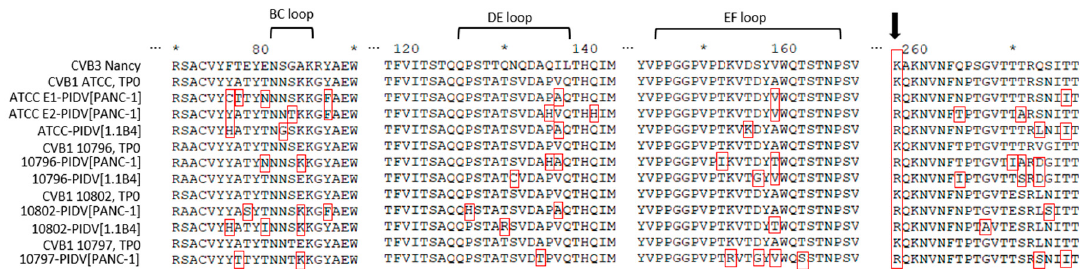
Figure 6. Non-synonymous mutations in PIDVs, marked with red frames, accumulated in the BC loop, DE loop and EF loop regions and at the end of the VP1 protein at TP2. Mutation K257R is indicated with an arrow.